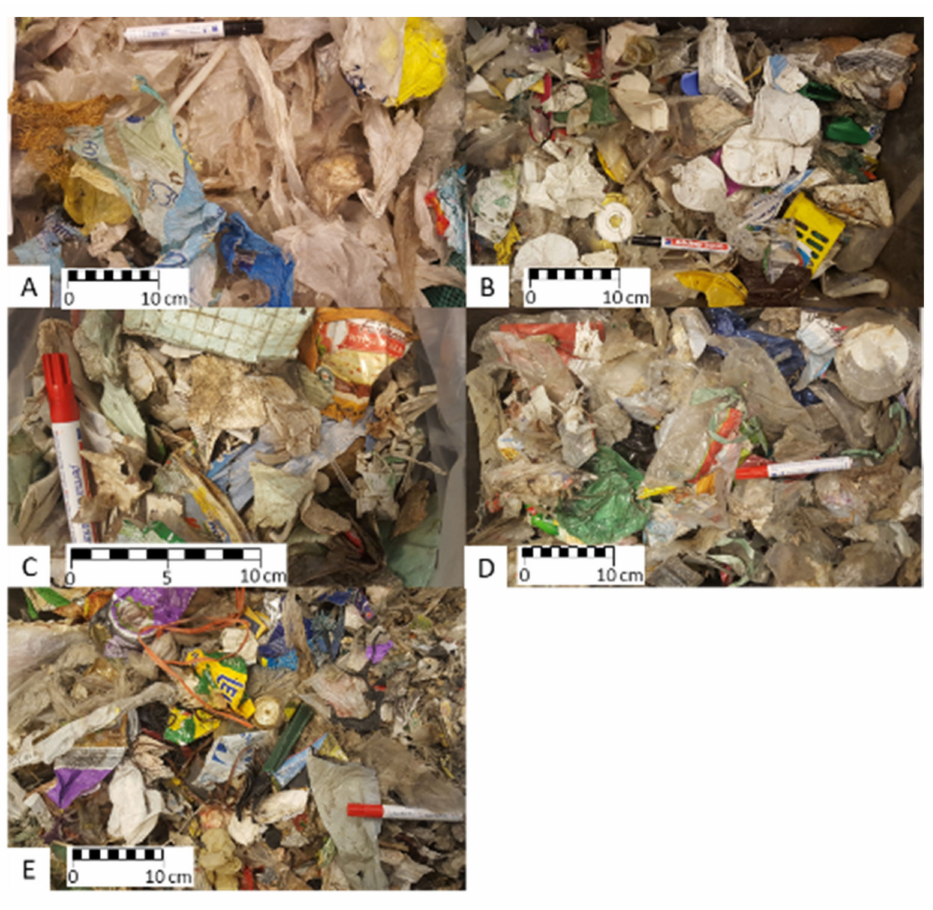
Figure 11. Exemplary photos of plastic types sorted with NIR: PE—( A ); PP—( B ); PET—( C ); PS—( D ); and others—( E )